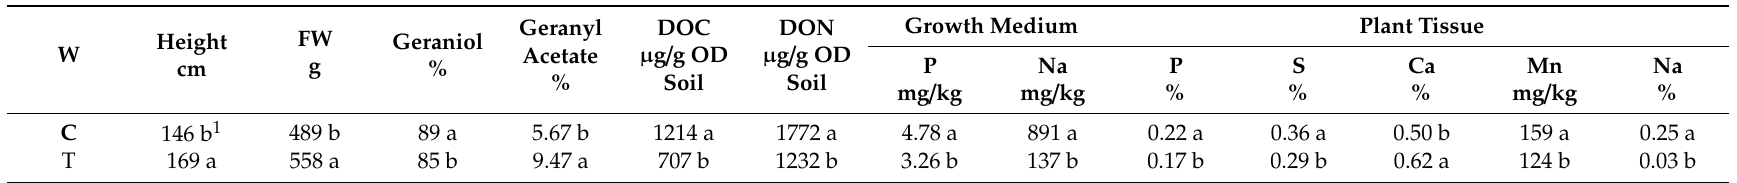
Table 5. Mean height, fresh weight (FW), oil composition (Geraniol and Geranyl Acetate); soil microbial C and N flush [DOC (ug / g OD soil), and DON (ug / g OD soil)]; growth medium available nutrients [phosphorus (P) and sodium (Na)], and nutrient content of plant tissue from distillation waste [P, sulfur (S), calcium (Ca), manganese (Mn), and Na] obtained from coal-bed methane (C) water (W) and Tap water (T) of the palmarosa